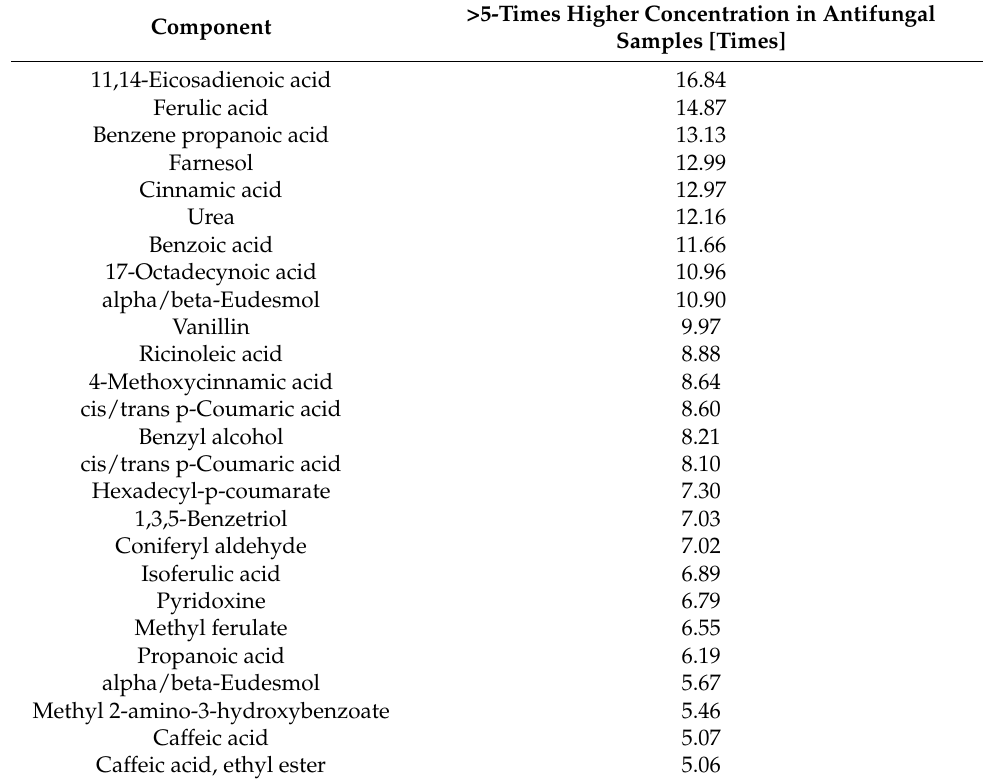
Table 2. Relative dominance of chemicals in antifungal samples. The ratios of chemical concentra- tions (high-antifungal-activity/low-antifungal-activity sample) showing more than 5 times higher concentration in antifungal samples. The original data were obtained from GC-MS measurement and calculated from the area values. >5-Times Higher Concentration in Antifungal Component Samples